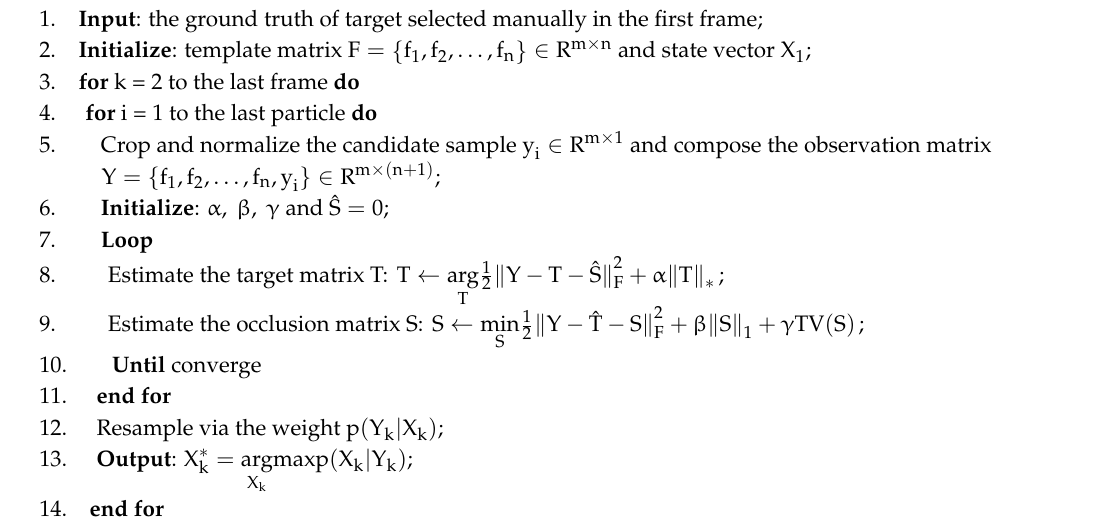
Algorithm 3. Complete steps of the proposed